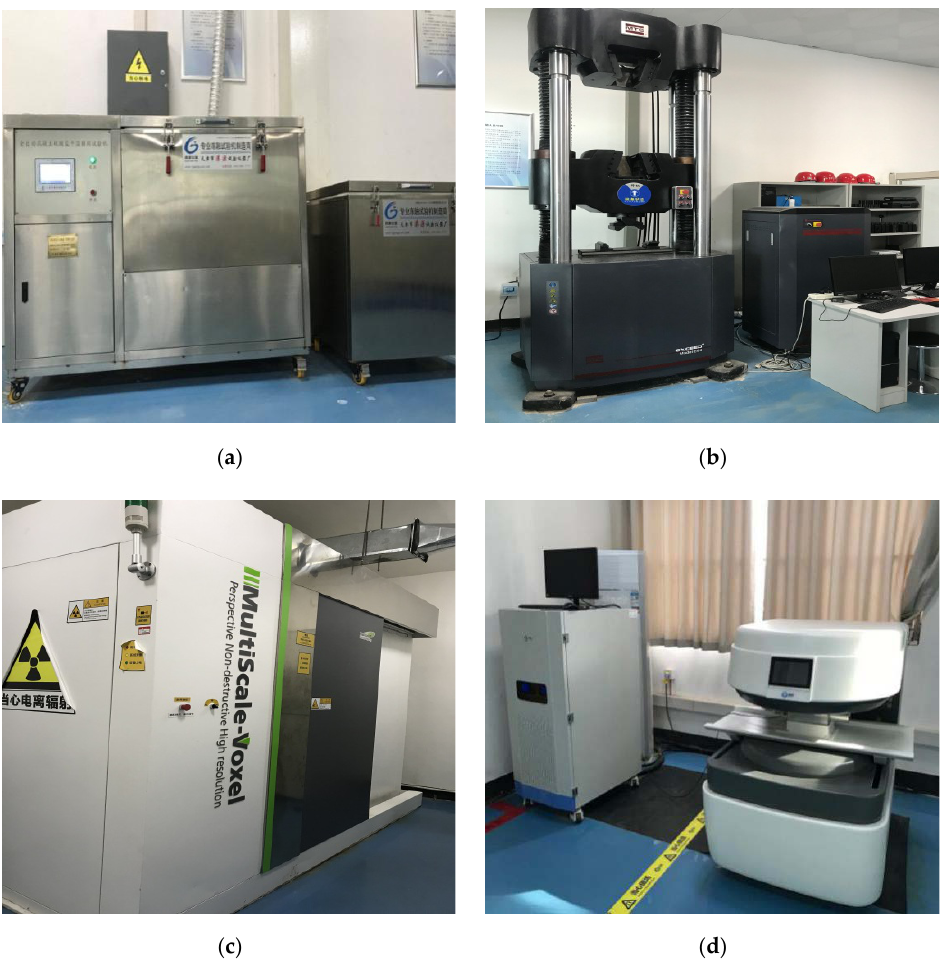
Figure 1. Test instruments and equipment: ( a ) The fully automatic machine for dry–wet circulation of sulfate; ( b ) MTS universal testing machine; ( c ) ICT; ( d ) The MacroMR 12-150H-I instrument.